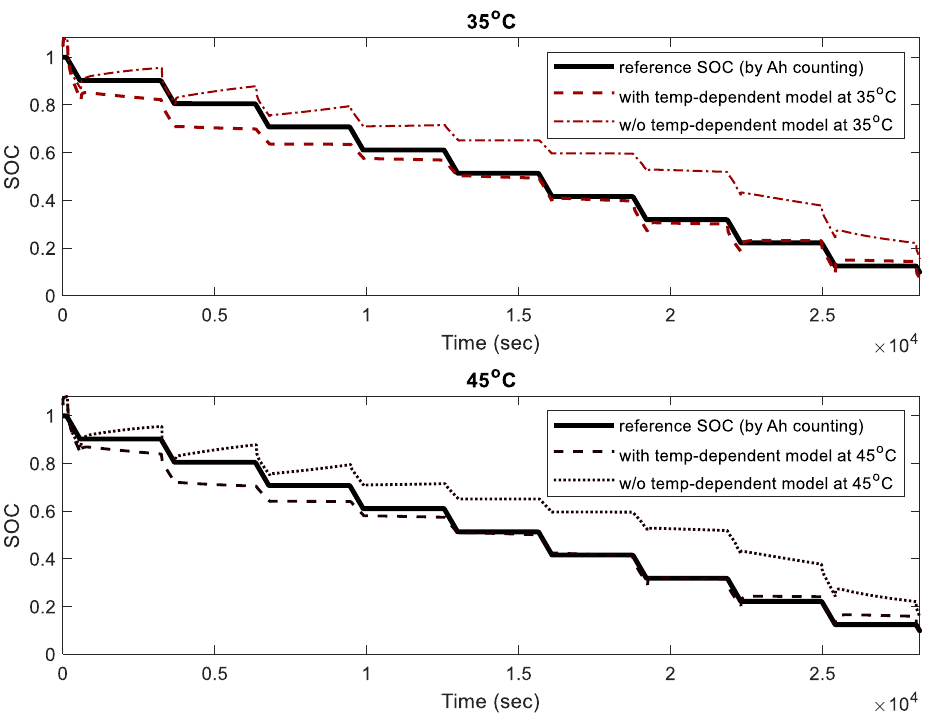
Figure 23. SOC as compared to experimental result at different ambient temperature (35 °C and 45 °C).